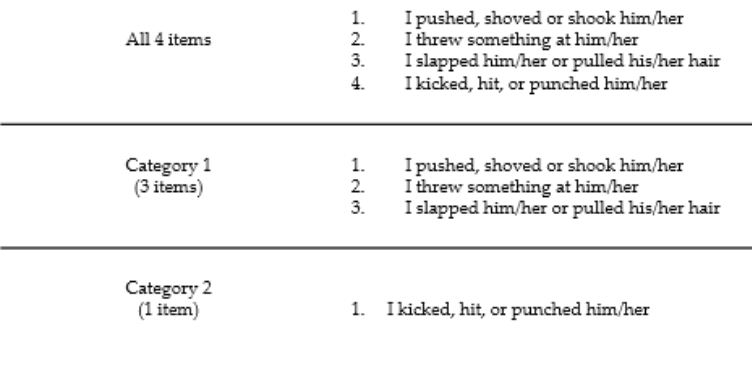
Figure 1. Categories derived from the CADRI physical abuse